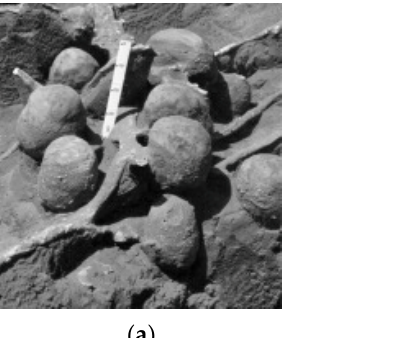
Figure 3. ( a , b ) The process of nesting construction of Camponotus japonicus.